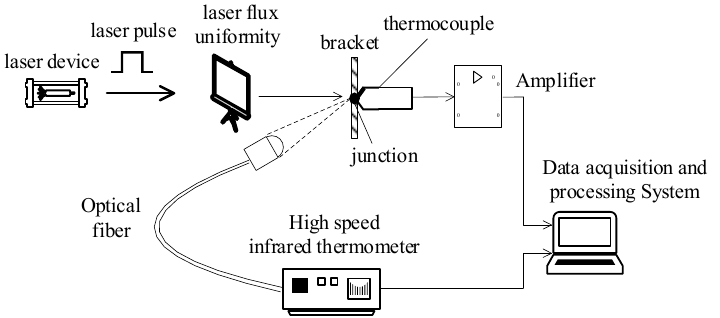
Figure 3. Transient temperature calibration system.